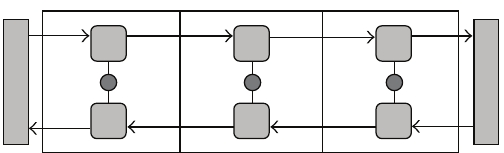
Figure 16: Three stages of a pipeline. Each stage uses two quarters and the synchronizer (filled circle) of a